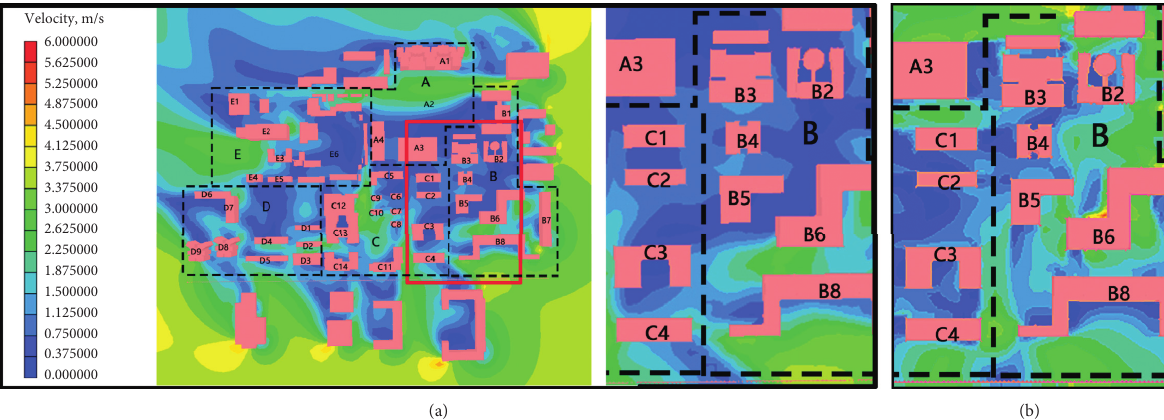
Figure 16: The comparison picture before and after implementation of optimization. (a) The original; (b) the